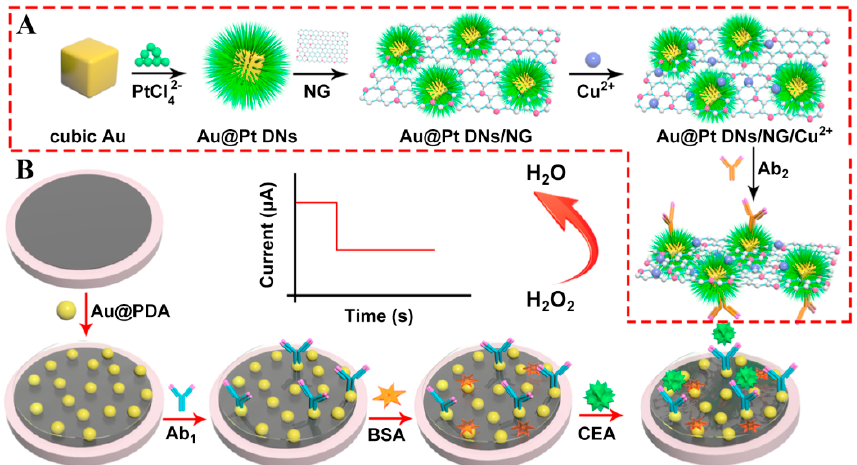
Figure 3. ( A ) The preparation procedures of Au@Pt DNs/NG/Cu 2+ -Ab 2 . ( B ) The fabrication process of the sandwich-type electrochemical immunosensor. Reprinted with permission from ref. [41].